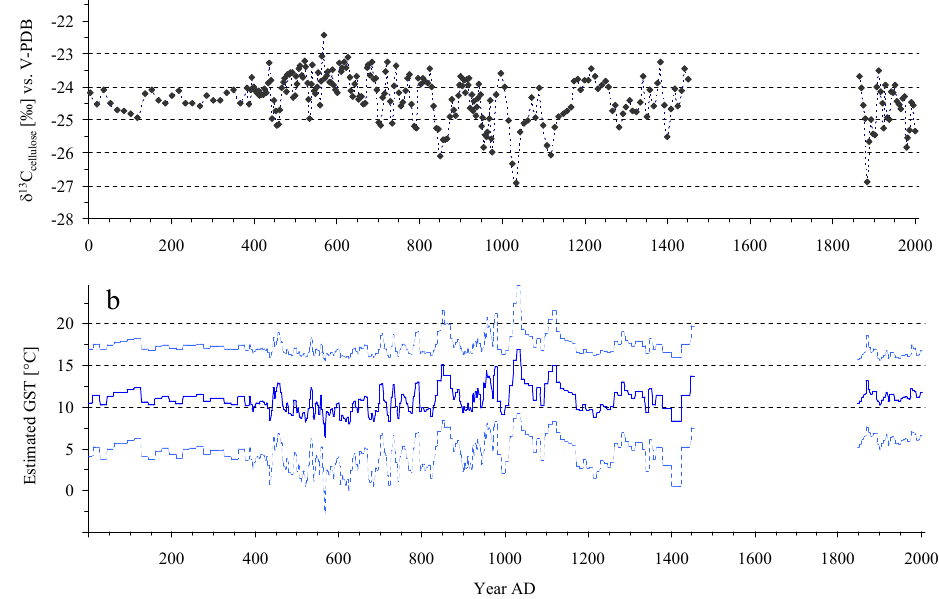
Fig. 5. The stable carbon isotope composition of Sphagnum cellulose (a) in combination with the estimated growing season temperature at D¨urres Maar (b) . On the basis of our age-depth model, a top age and a bottom age for each sample was calculated narrowing the time span and 2 cm peat increment accumulated to a specific number of years. Calculating a top and bottom age for each individual sample, thus, enabling the generating of estimated temperature values for each year of the time period under investigation. They are given in Fig. 5b which also contains the lower and upper limit of the prediction interval. Due to the dispersed small quantity of values (10 for S. magellanicum and 7 for S. capillifolium ) the predicted error is relatively